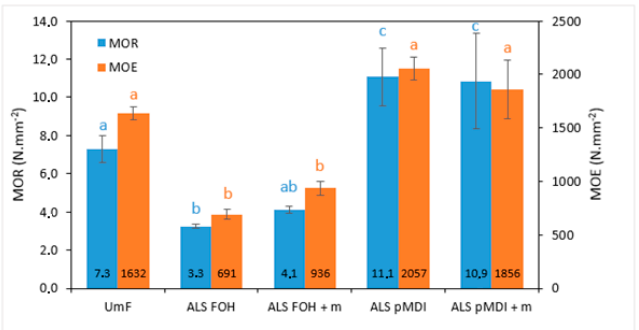
Figure 7. MOR (modulus of rupture, blue bars) and MOE (modulus of elasticity, orange bars) of particleboards produced with urea-melamine-formaldehyde (UmF), ammonium lignosulfonate (ALS) crosslinked with furfuryl alcohol (ALS FOH), ALS FOH with mimosa tannin (ALS FOH + m), ALS crosslinked with pMDI (ALS pMDI) and ALS pMDI with mimosa tannin (ALS pMDI + m). Error bars represent standard deviations. Values labeled with di ff erent letters (a, b, and c) are statistically di ff erent at an error probability of α = 0.05 (ANOVA and Tukey’s HSD tests). Value marked ab is not statistically di ff erent from a or b. Di ff erent colored letters refer to the matching mechanical